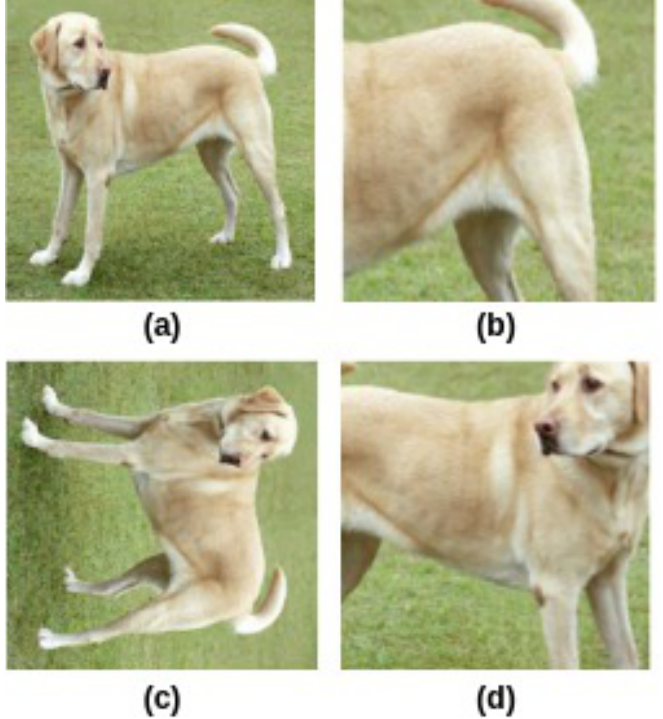
Figure 5. Geometric transformation as pretext task [15]. ( a ) Original. ( b ) Crop and resize. ( c ) Rotate (90 ◦ , 180 ◦ , 270 ◦ ). ( d ) Crop, resize, and flip.